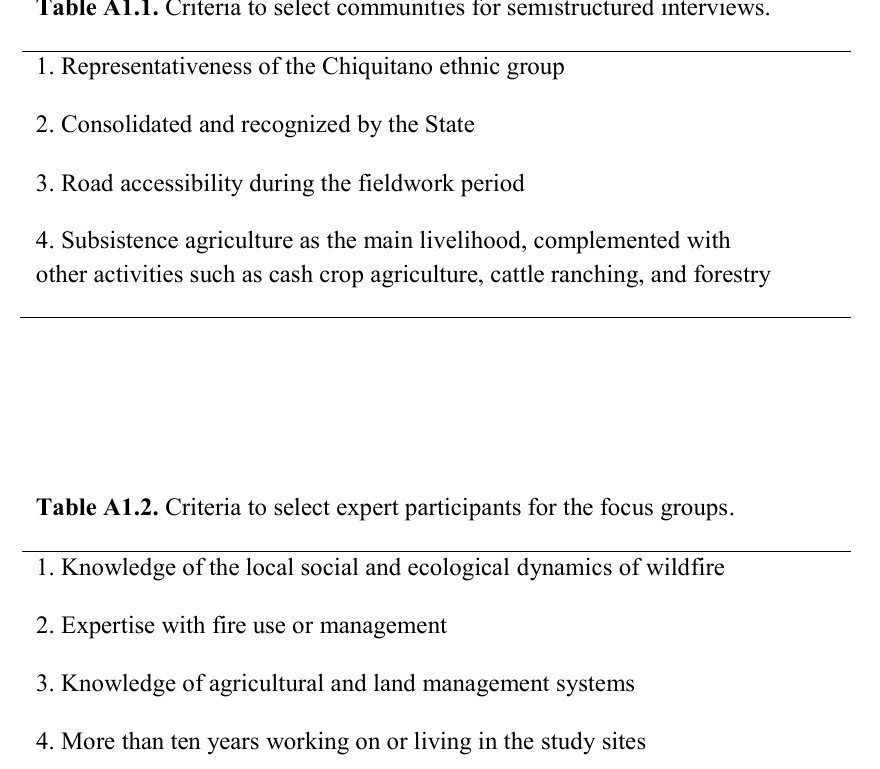
Table A1.1. Criteria to select communities for semistructured interviews.